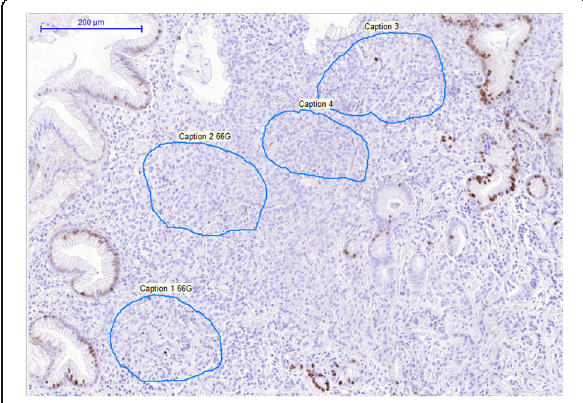
Fig. 1 Image scanning for quantitative immunohistochemical analysis and areas of "hot-spot selected for